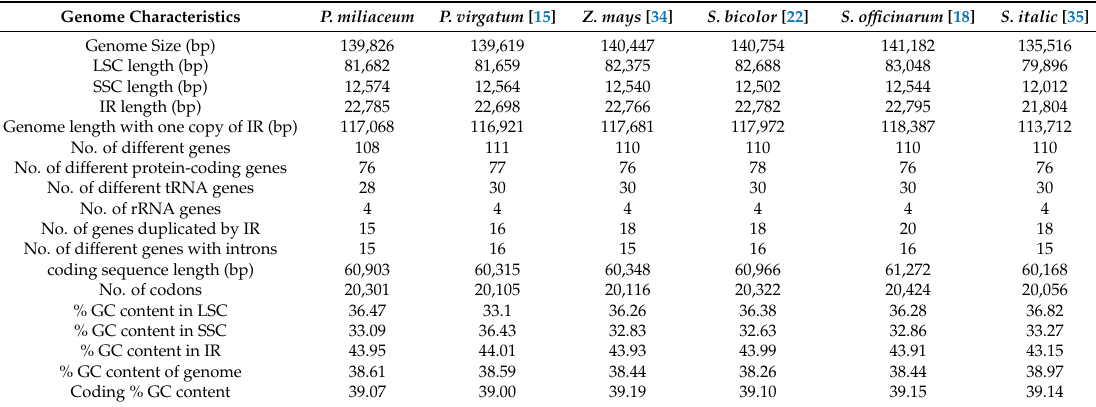
Table 1. Comparisons of CpDNA features among the six Panicoideae